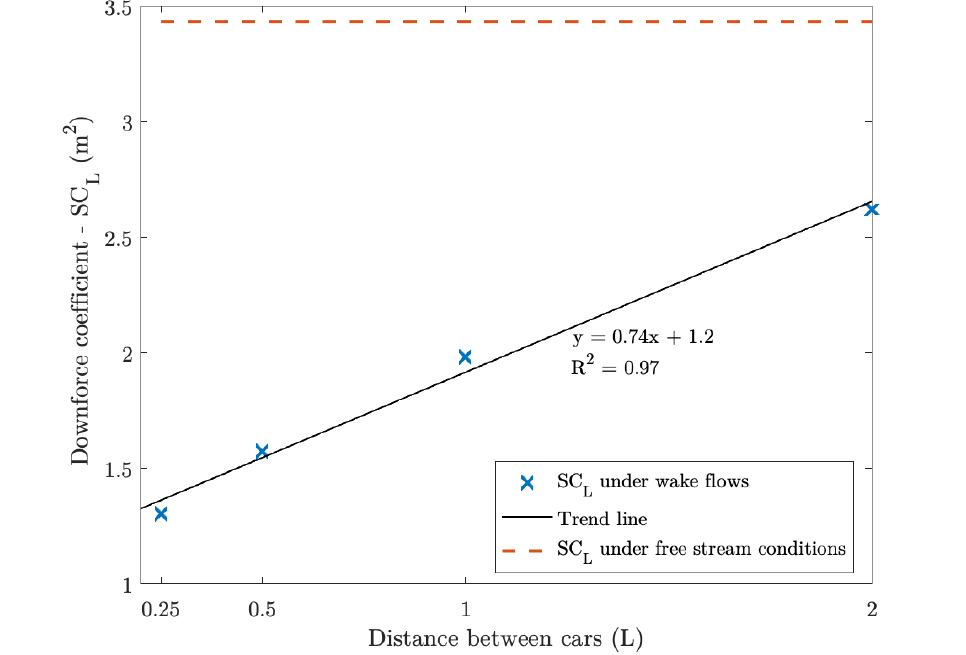
Figure 12. Comparison between values of S C L under wake flows and under free stream